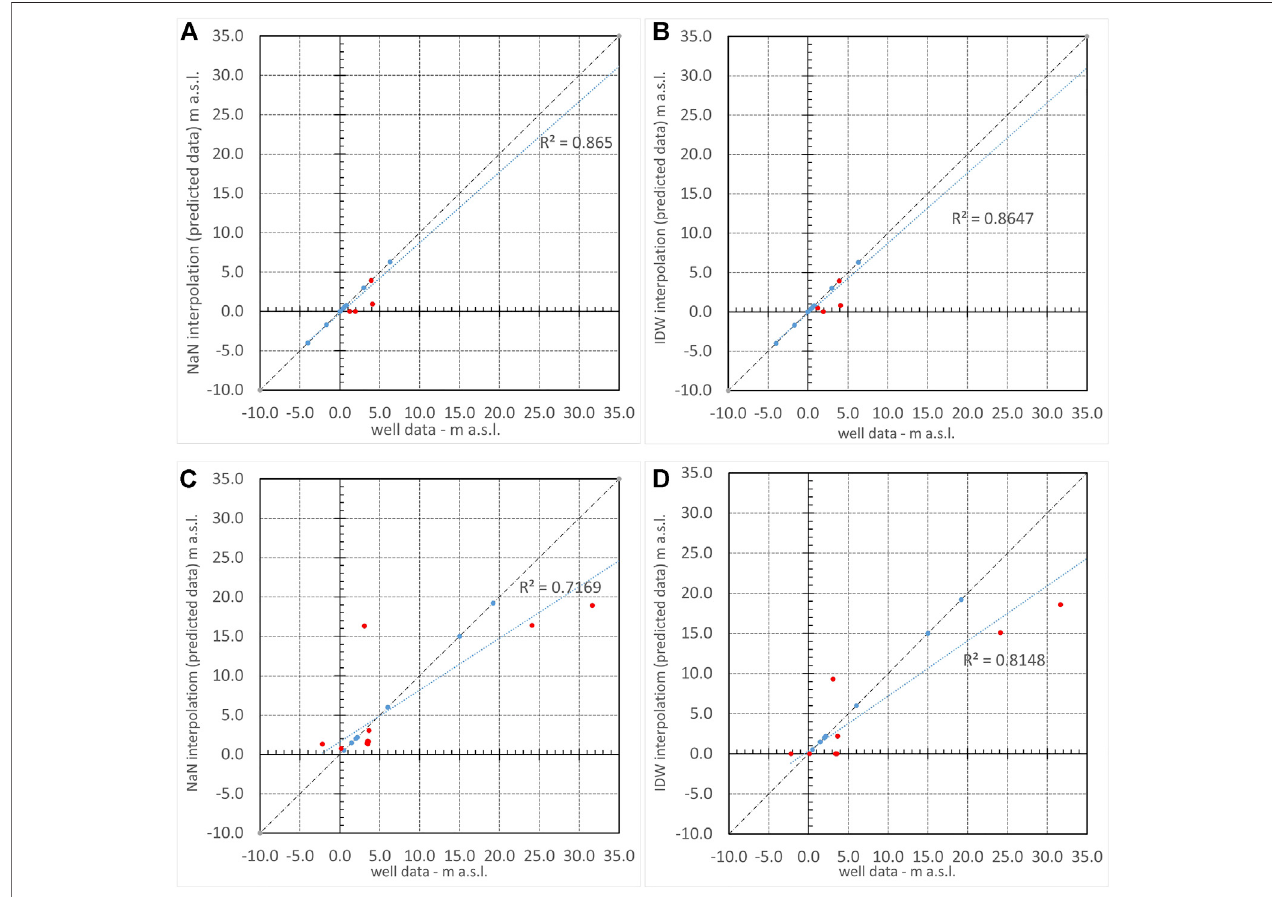
FIGURE11| Correlationbetweenthemeasuredgroundwaterlevel(welldata)andthepredictedvalues(derivedfromtheinterpolationmodel)duringthedryseason in the Casamicciola – Lacco Ameno sector: (A) NaN interpolation and (B) IDW interpolation, and the Citara sector: (C) NaN interpolation and (D) IDW interpolation. Blue dots correspond to available data; red dots correspond to complementary fi eld groundwater level measurements.